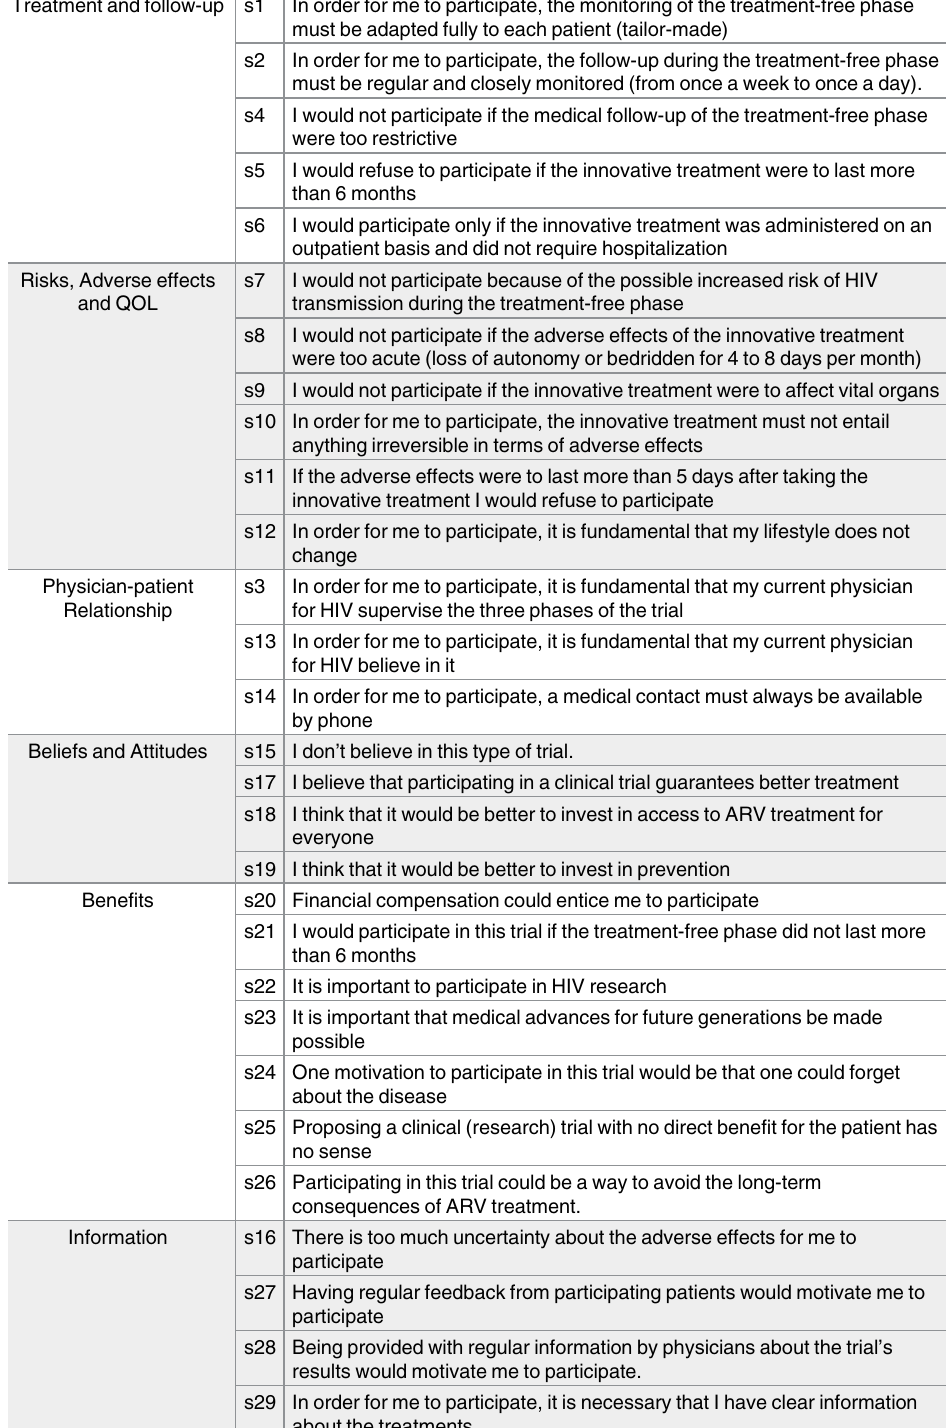
Table 1. Description of persons living with HIV